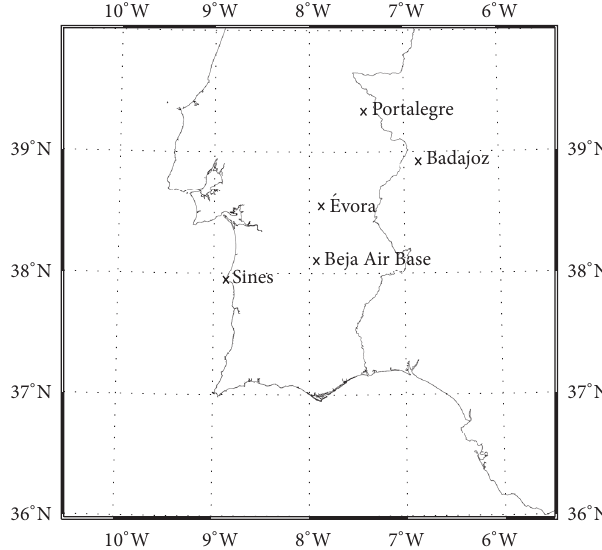
Figure 2: Meteorological stations in model domain